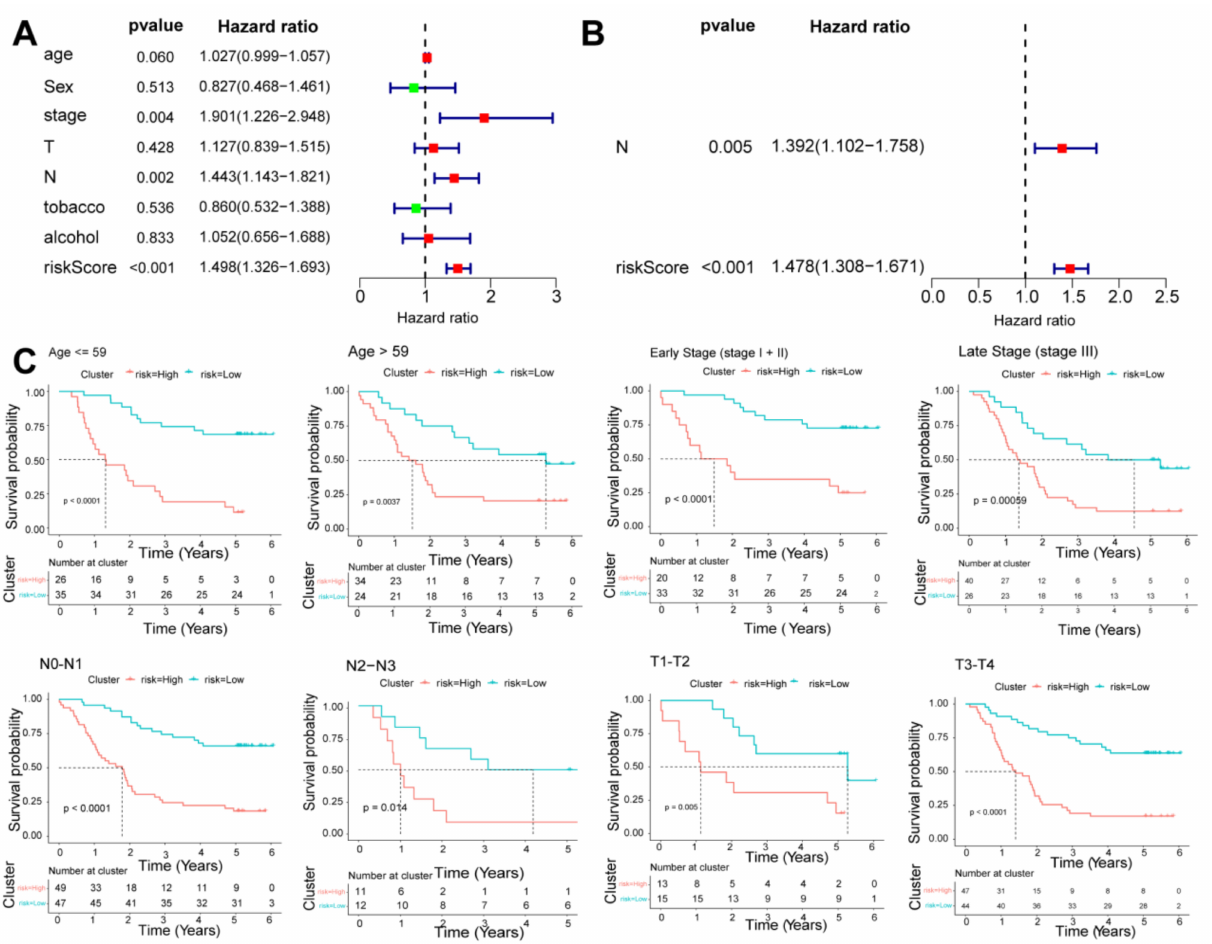
Figure 5. A stratified K-M survival analysis across different clinical features in GSE53624. Univariate ( A ) and multivariate ( B ) Cox regression analyses of the association between clinicopathological factors and overall survival (OS) of patients in GSE53624 dataset. ( C ) K-M survival curves for OS in multiple subgroups based on the six-DEARlncRNA risk